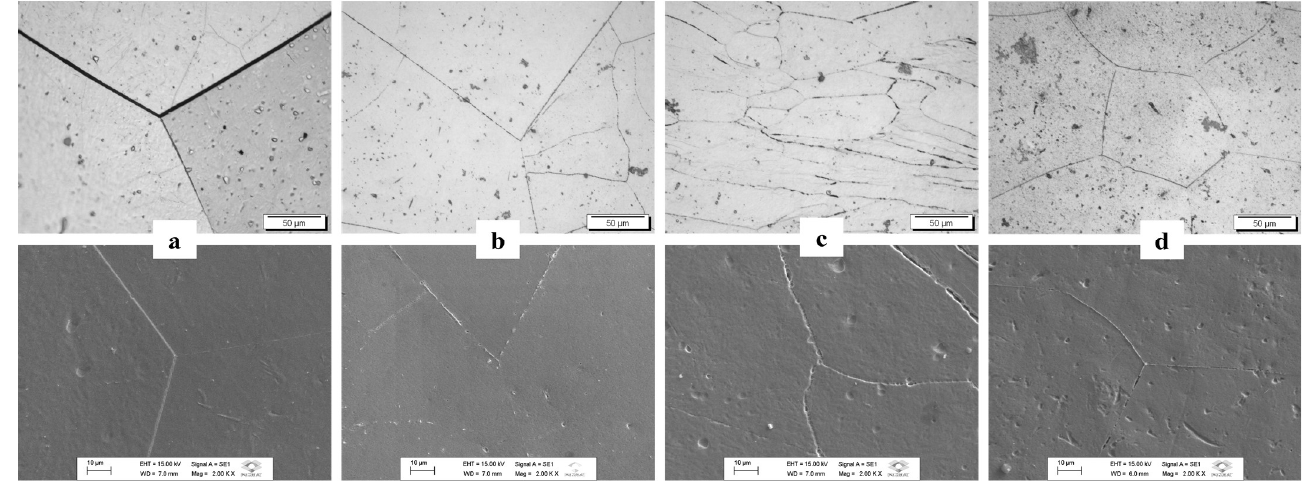
Figure 6. Optical micrographs (above) and SEM micrographs (below) in as-cast ( a ), homogenized ( b ), hot rolled ( c ), and annealed ( d ) conditions, for Ti-30Nb-5Mo samples. The Vickers microhardness values of the studied samples are displayed in Figure 7.